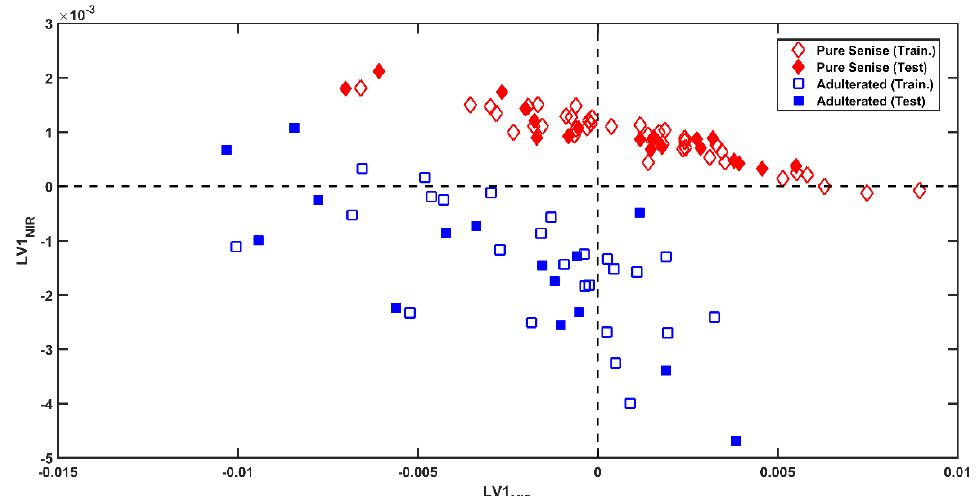
Figure 2. Sequential and orthogonalized partial least squares linear discriminant analysis (SO-PLS-LDA) analysis: projection of the training (empty symbols) and test (filled symbols) samples onto the sub-space spanned by the first LV extracted from the MIR block (LV1 MIR ) and the first LV extracted from the NIR block (LV1 NIR ). Legend: pure Senise: red diamonds; adulterated: blue squares.